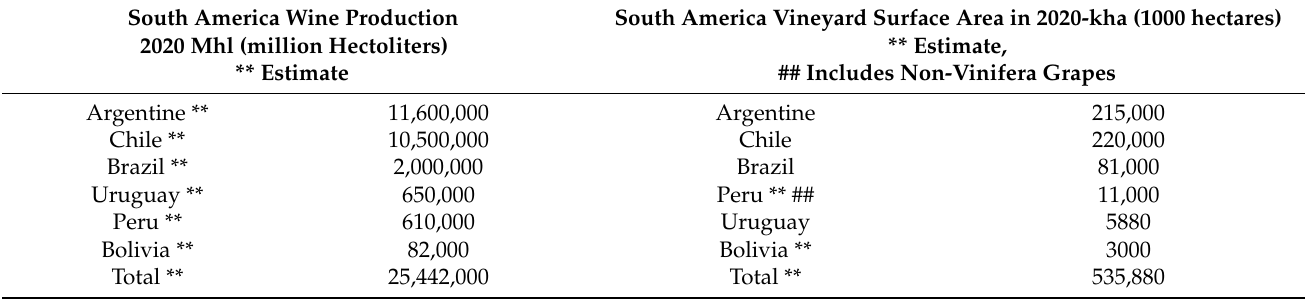
Table 2. Estimate of wine production output and vineyard surface in South